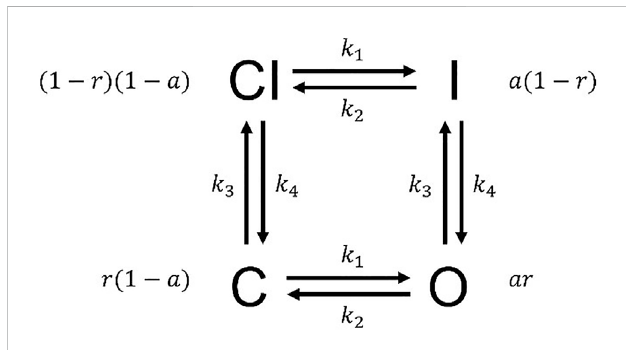
FIGURE 3 The Hodgkin – Huxley model structure. The probabilities for states